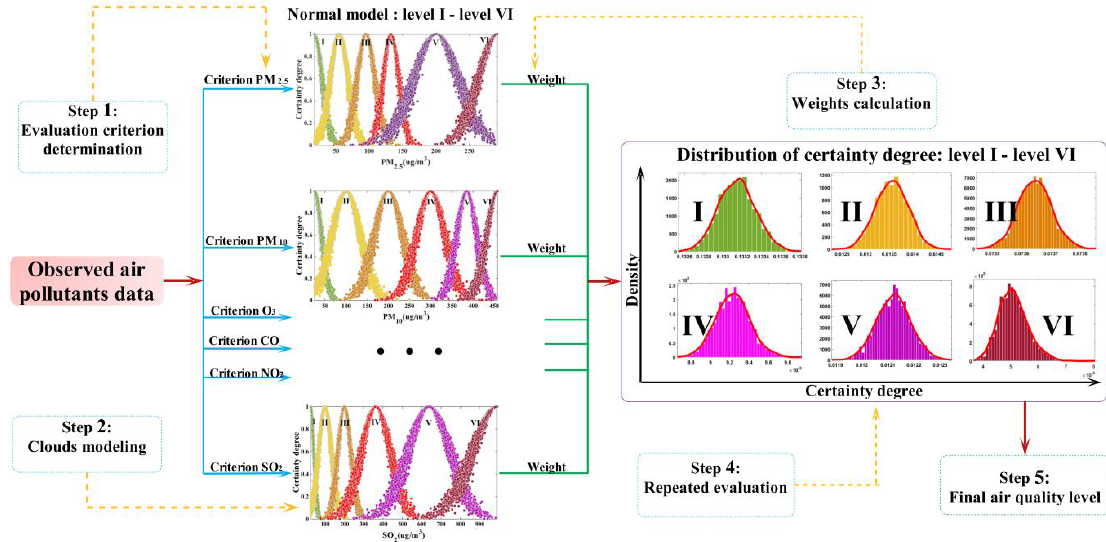
Figure 3. The cloud modeling workflow.